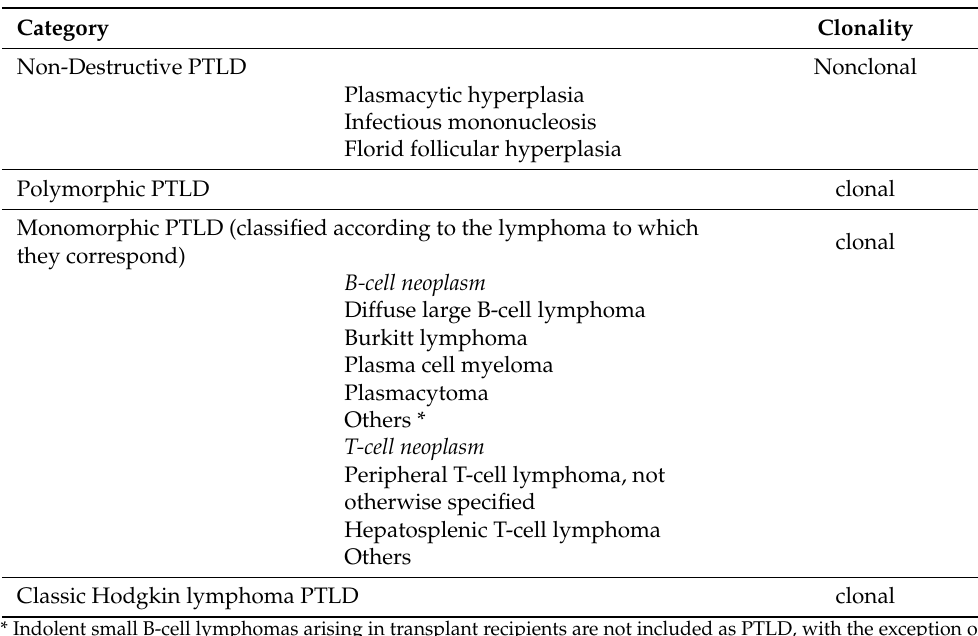
Table 3. Histopathological classification of post-transplant lymphoproliferative disorders (PTLD) (2016, WHO classification) and clonal